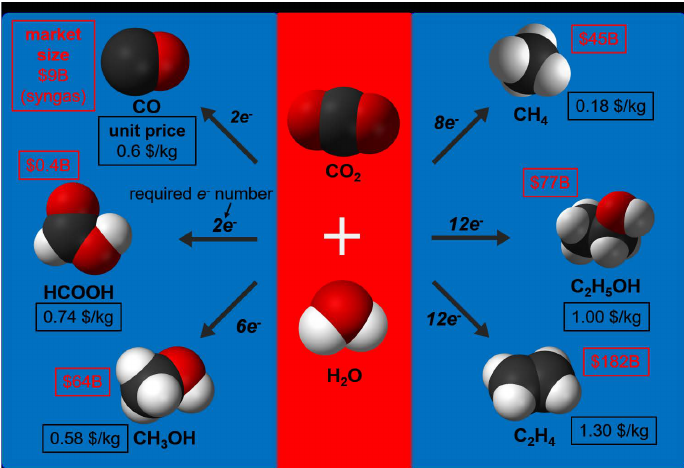
Figure 1. Various possible routes for the products from the CO 2 reduction reaction. The market size, unit price, and required number of electrons for producing each chemical are marked in the schematic [1].